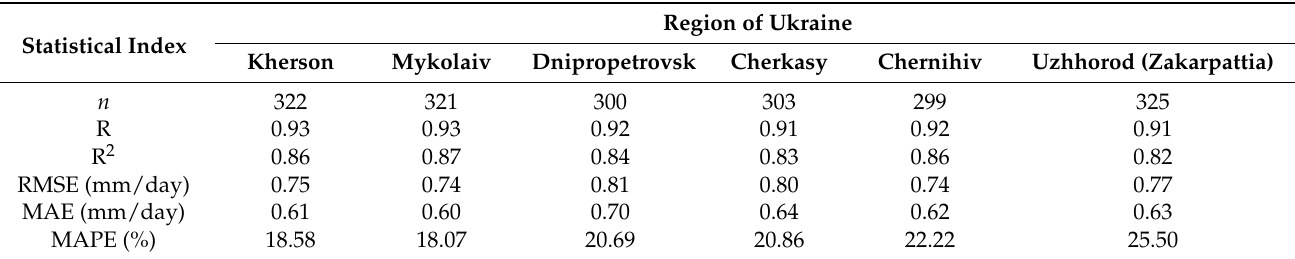
Table 1. Statistical indices of ETo Calculator (Ukraine) mobile app accuracy comparing to Penman– Monteith method of reference evapotranspiration assessment (daily scale).